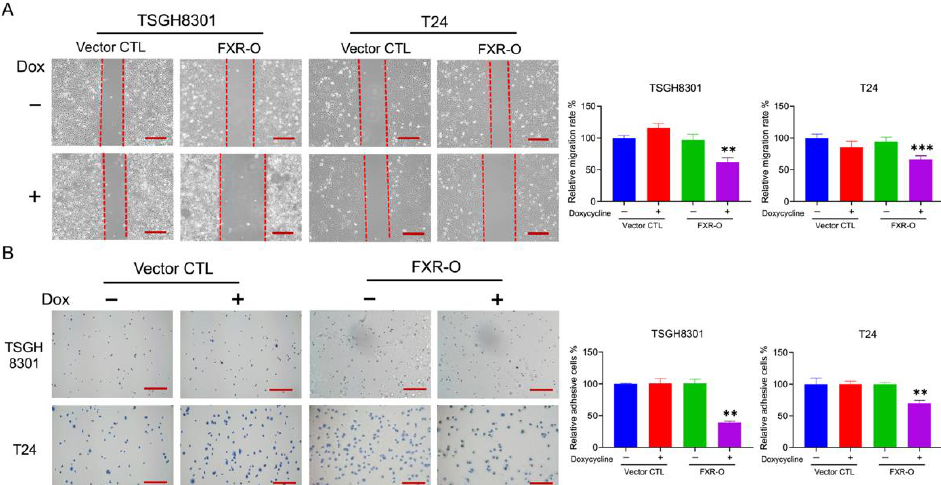
Figure 2. The effect on migration and adhesion abilities after FXR overexpression. ( A ) Wound healing migration assays were performed in FXR-overexpressed (FXR-O) TSGH8301 and T24 human bladder cancer cells after 6 h scratch. The right panels display the relative rate of the wound healing migratory ability. ** p < 0.01; *** p < 0.001 compared to the control group. ( B ) Adhesion assays were performed in FXR-O TSGH8301 and T24 cells after 50 min of incubation. Thereafter, the adhered cells were stained and captured. The right panels display the relative rate of the adhesive ability. ** p < 0.01 compared to the control group. Scale bar = 200 μm.